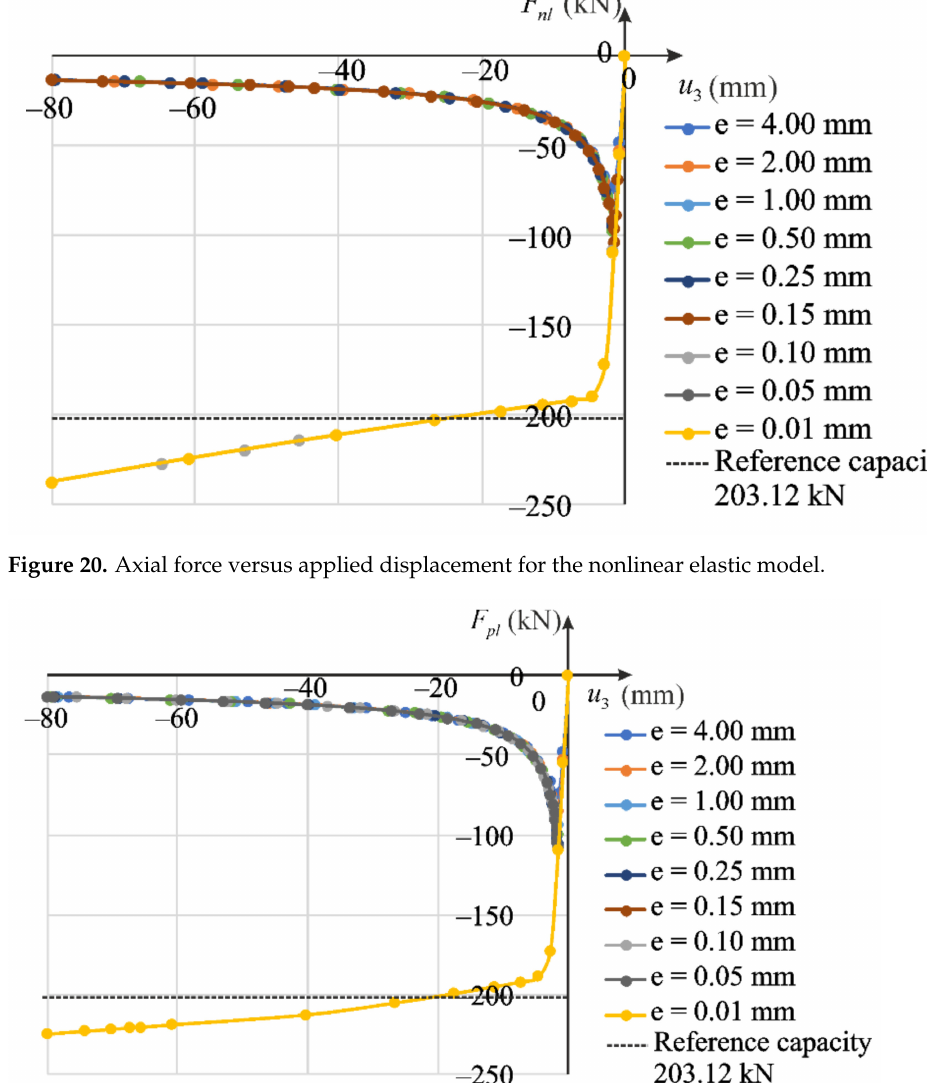
Figure 21. Axial force versus applied displacement for the elastic-plastic